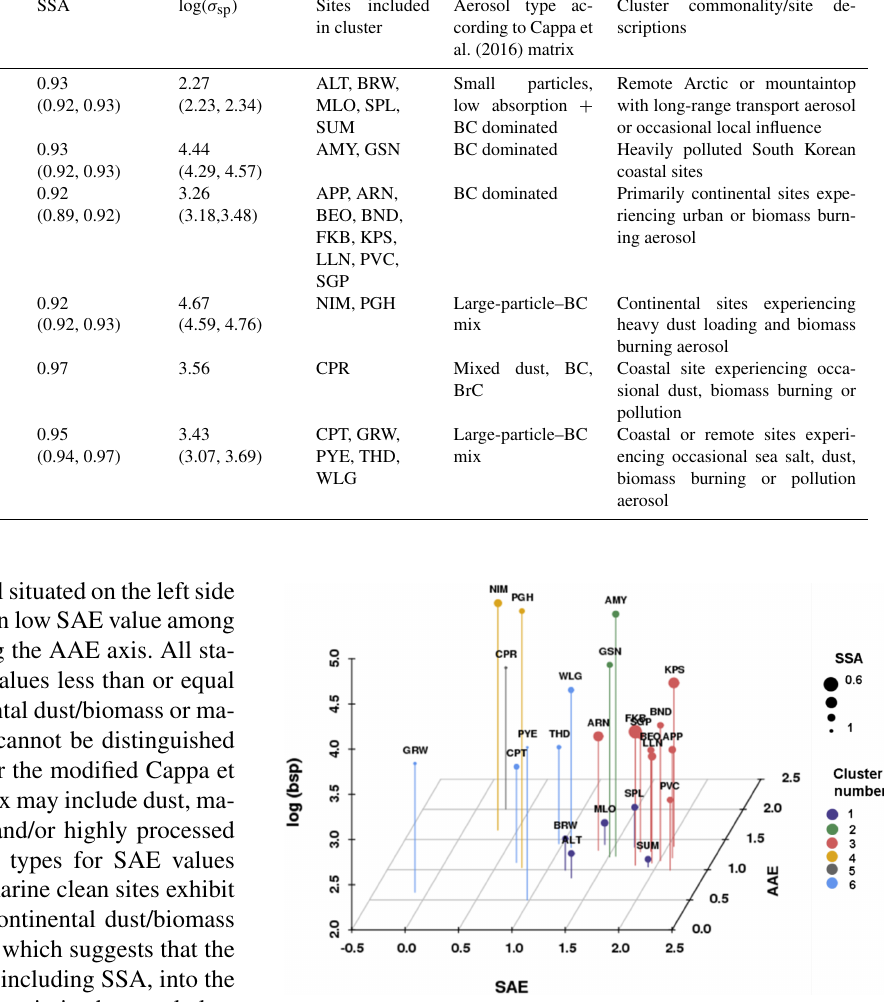
Figure 3. Three-dimensional parameter space of SAE vs. AAE vs. log of scattering coefficient, σ sp (Mm − 1 ) . Station points are colored by cluster number resulting from the clustering analysis and sized by median SSA